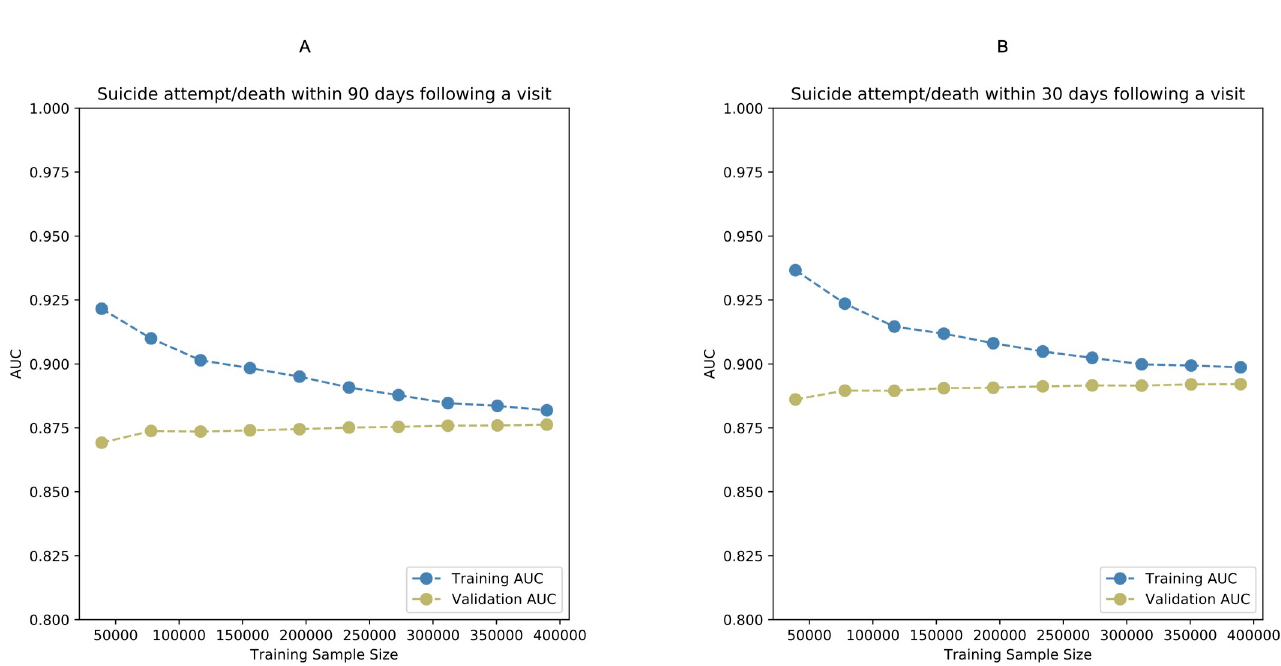
Fig 3. Learning curves illustrating bias and variance trade-off in the training set for predicting suicide attempt/death within 90 (A) and 30 days (B) following a visit to psychiatric specialty care during 2011 and 2012. The figure was based on the calibration of the ensemble models. AUC, area under the receiver operating characteristic